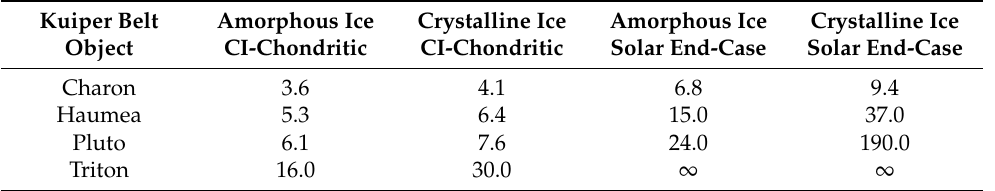
Table 1. Refractory-to-water-ice mass ratios δ w of Kuiper Belt Objects